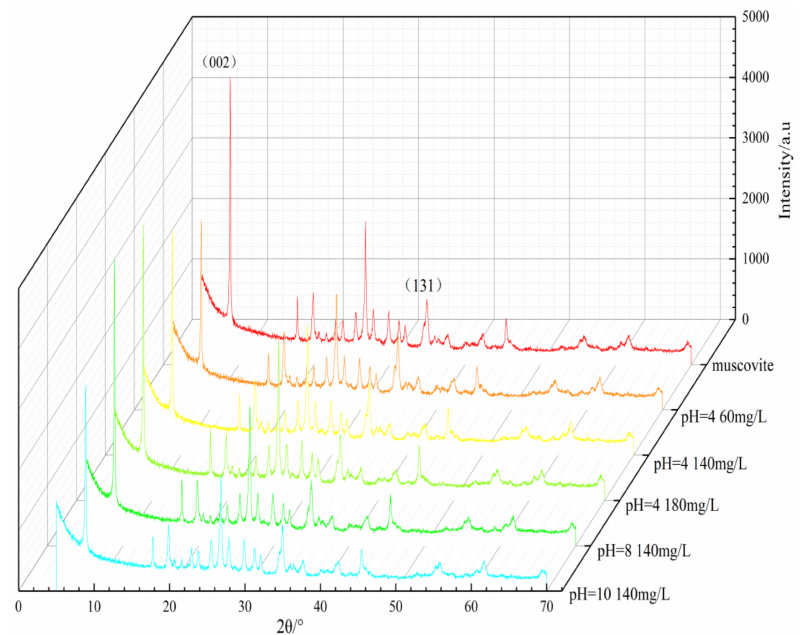
Figure 16. The XRD of muscovite (002) and (131) crystal planes under different flotation